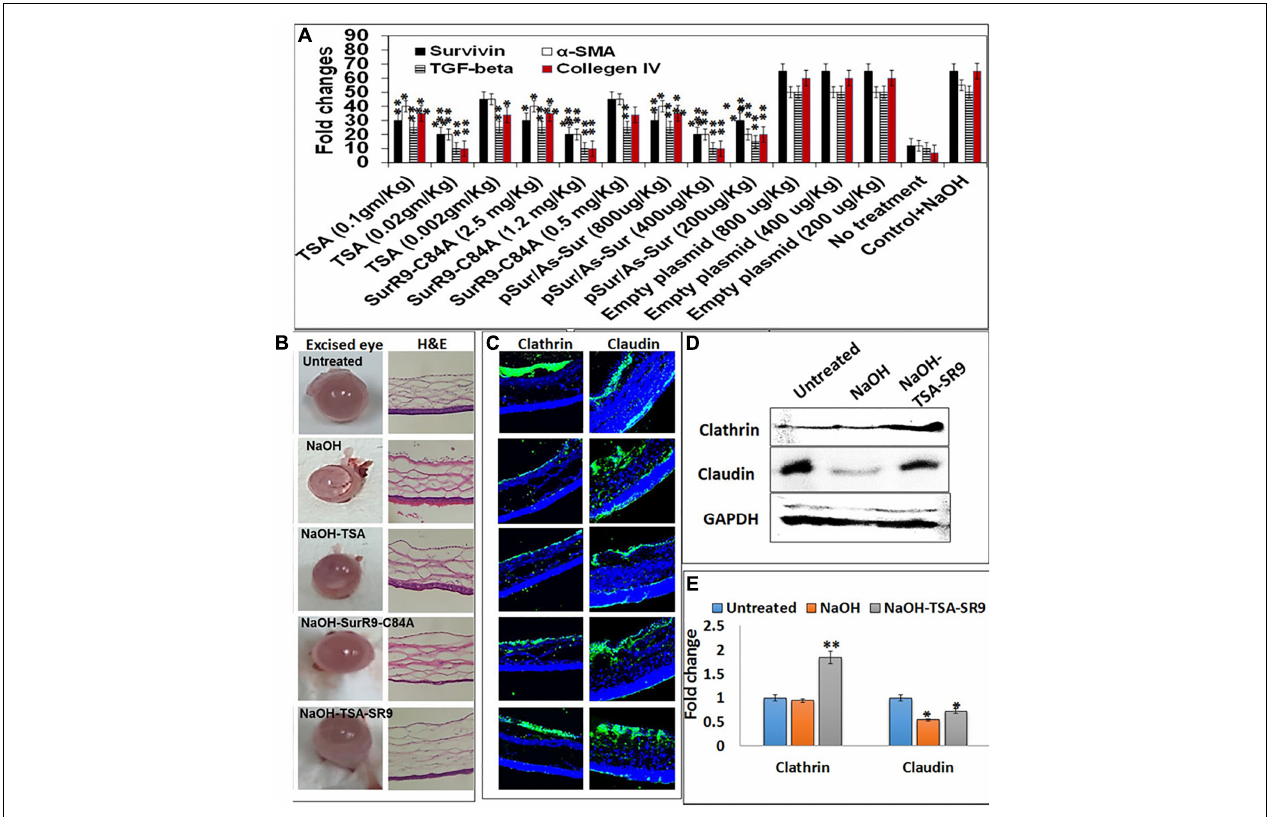
FIGURE 1 | Change in corneal tissue integrity post-alkali burn: (A) Gene expression analysis to determine the effective dosage of TSA and SurR9-C84A using ex vivo rat eyes. (B) Rat eyes were exposed to 1 M NaOH for 1 min and then treated with TSA or SurR9-C84A or a combination of both [TSA+SurR9-C84A(SR9)] for 40 min. The excised eyes were used to determine the opacity and inflammatory scores and H&E staining was performed to determine the effect of alkali burn and treatments on corneal tissue integrity. (C) Immunofluorescence staining for expression of clathrin in conjunctival layer and claudin in corneal layer was performed to determine the effect of alkali burn and treatments on corneal tissue integrity. (D) Western blotting analysis confirmed that both decrease in expressions of clathrin and claudin in rat corneal tissue lysates. Each blot was repeated thrice and a representative blot has been presented. (E) Band density analysis of western blot was performed using image J software. The experiments were conducted in five animals per treatment group. The H&E staining was performed on five slides obtained from each animal and a representative image has been presented. Five images of each treatment were taken for immunofluorescence studies and a representative image has been presented. ∗ p < 0.05, ∗∗ p < 0.01, and ∗∗∗ p <